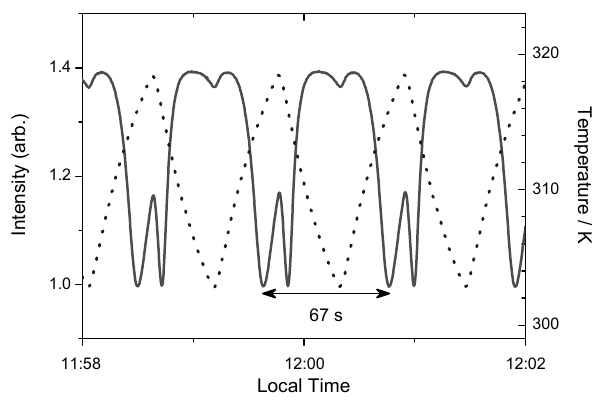
Fig. 12. Absorbance of CO 2 for determination of the effective to- tal photoabsorption cross section measured with neat CO 2 at room temperature in the laboratory.